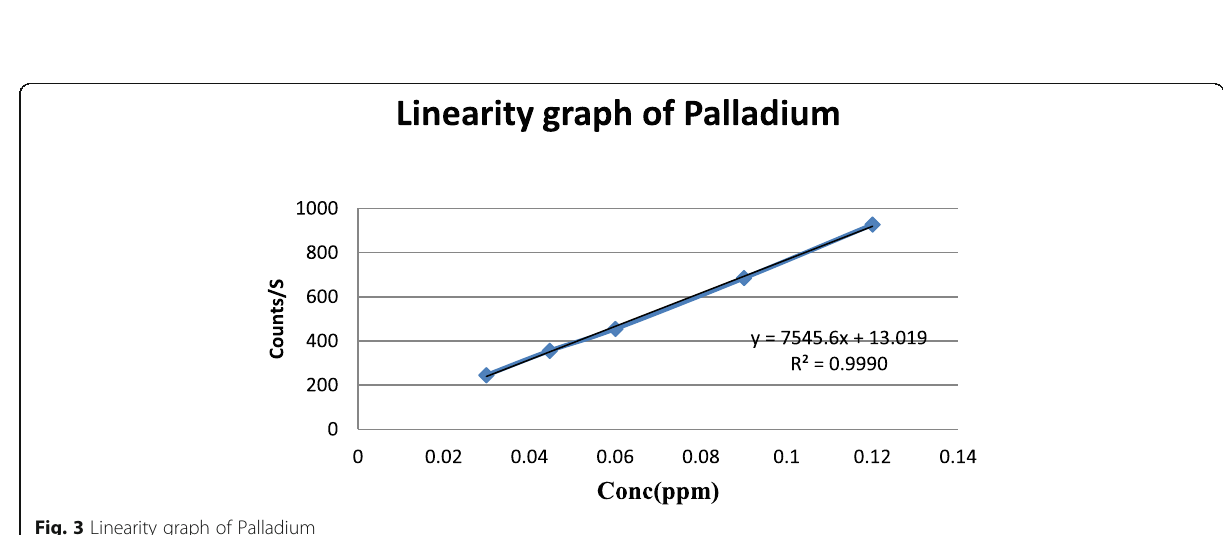
Fig. 3 Linearity graph of Palladium